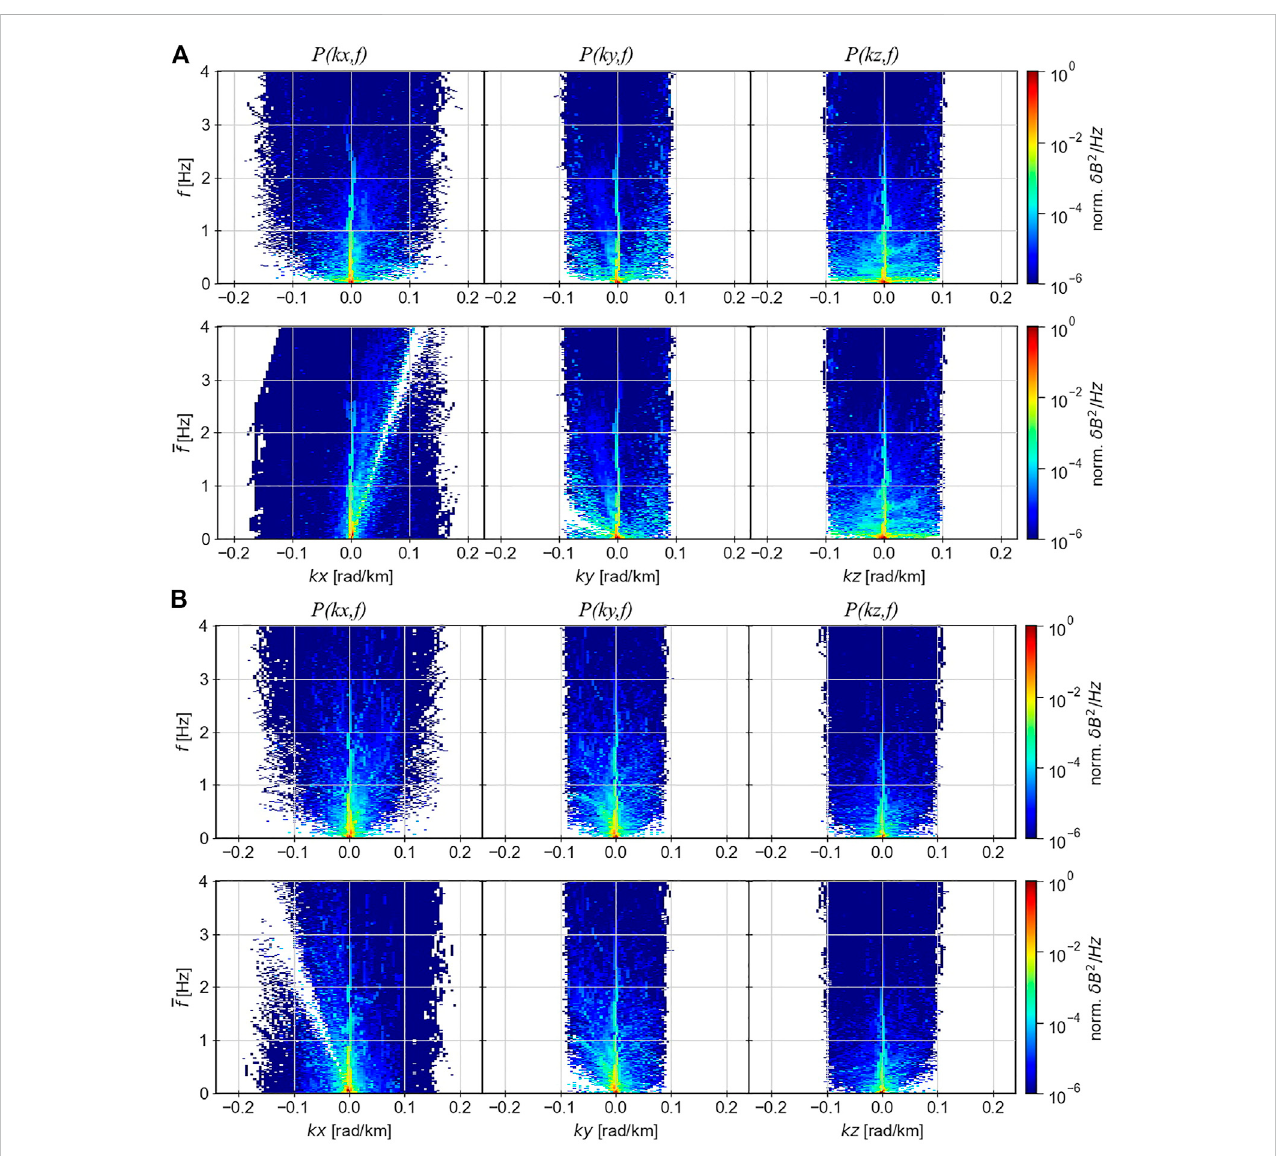
FIGURE 3 P (k,f) spectrum of the magnetic fi eld vector for (A) the fi rst event and (B) the second fl apping event 2020/08/26. The spectra panels with (cid:2) f on the Y -axis are plotted taking into account the Doppler